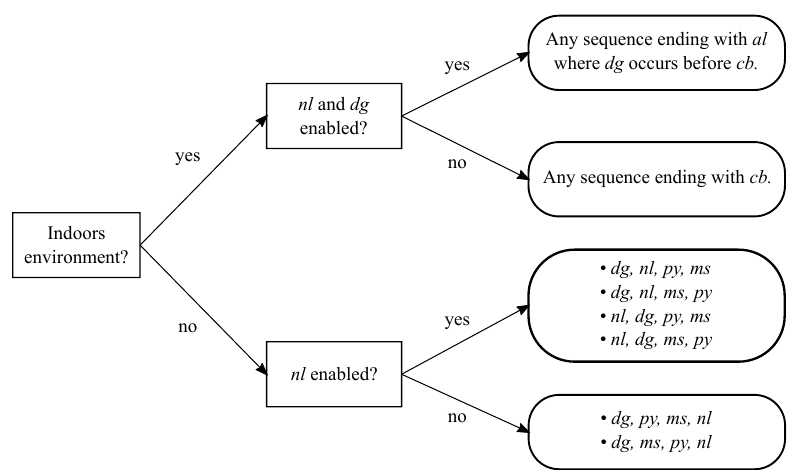
Figure 14. Visualisation of the decision process that leads to an optimal